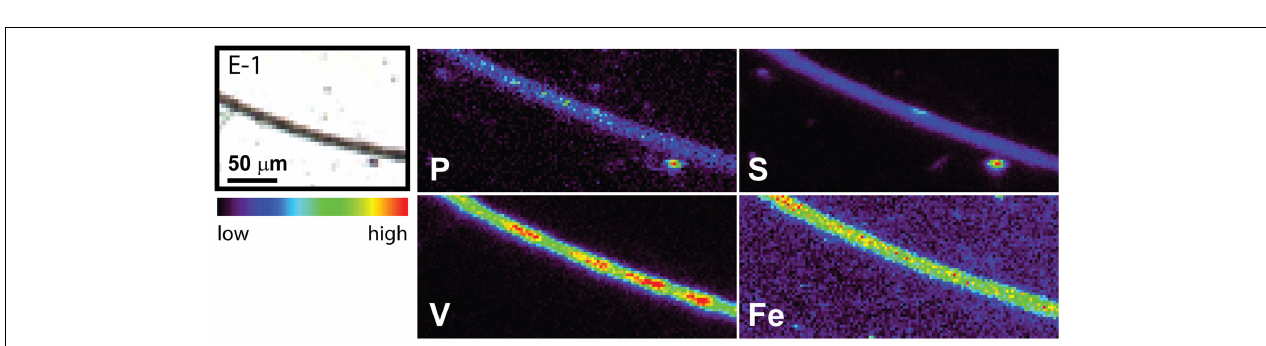
FIGURE 9 | Light micrographs, false-color element (P, S,V, Fe and Ni) maps, and differential phase contrast images (phase) (Hornberger et al., 2008) of a Trichodesmium trichome. The color scale for element maps is shown, with warmer colors indicating higher element concentrations.The color scheme of the differential phase